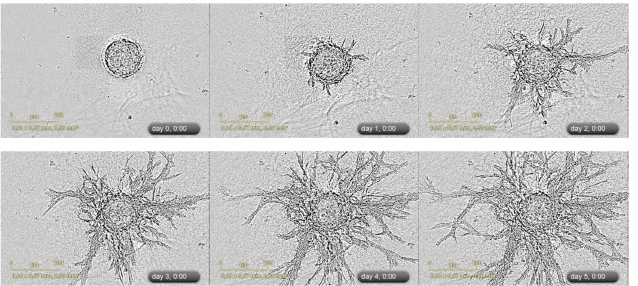
Figure 3. An example of 3D spheroid sprouting assay. Representative images of sprouting of heterotypic HUVEC-UCMSC 3D spheroids were acquired with IncuCyte Zoom imaging system (Sartorius, Bohemia, NY, USA). Corresponding video file S1 is available in the Supplementary Materials. The suspension of cells containing HUVECs and umbilical cord MSCs (cell ratio 1:1) was added (100 µ L per well) to the non-adhesive U-bottom 96-well plate (Corning, Waltham, MA, USA). After 72 h, the spheroids were collected and embedded in fibrin gel (4 mg/mL) that was supplemented with 20% platelet lysate (PL) and maintained at +37 ◦ C in CO 2 -incubator for 5 days. Phase-contrast microscopy (the scale bar corresponds to 200 µ